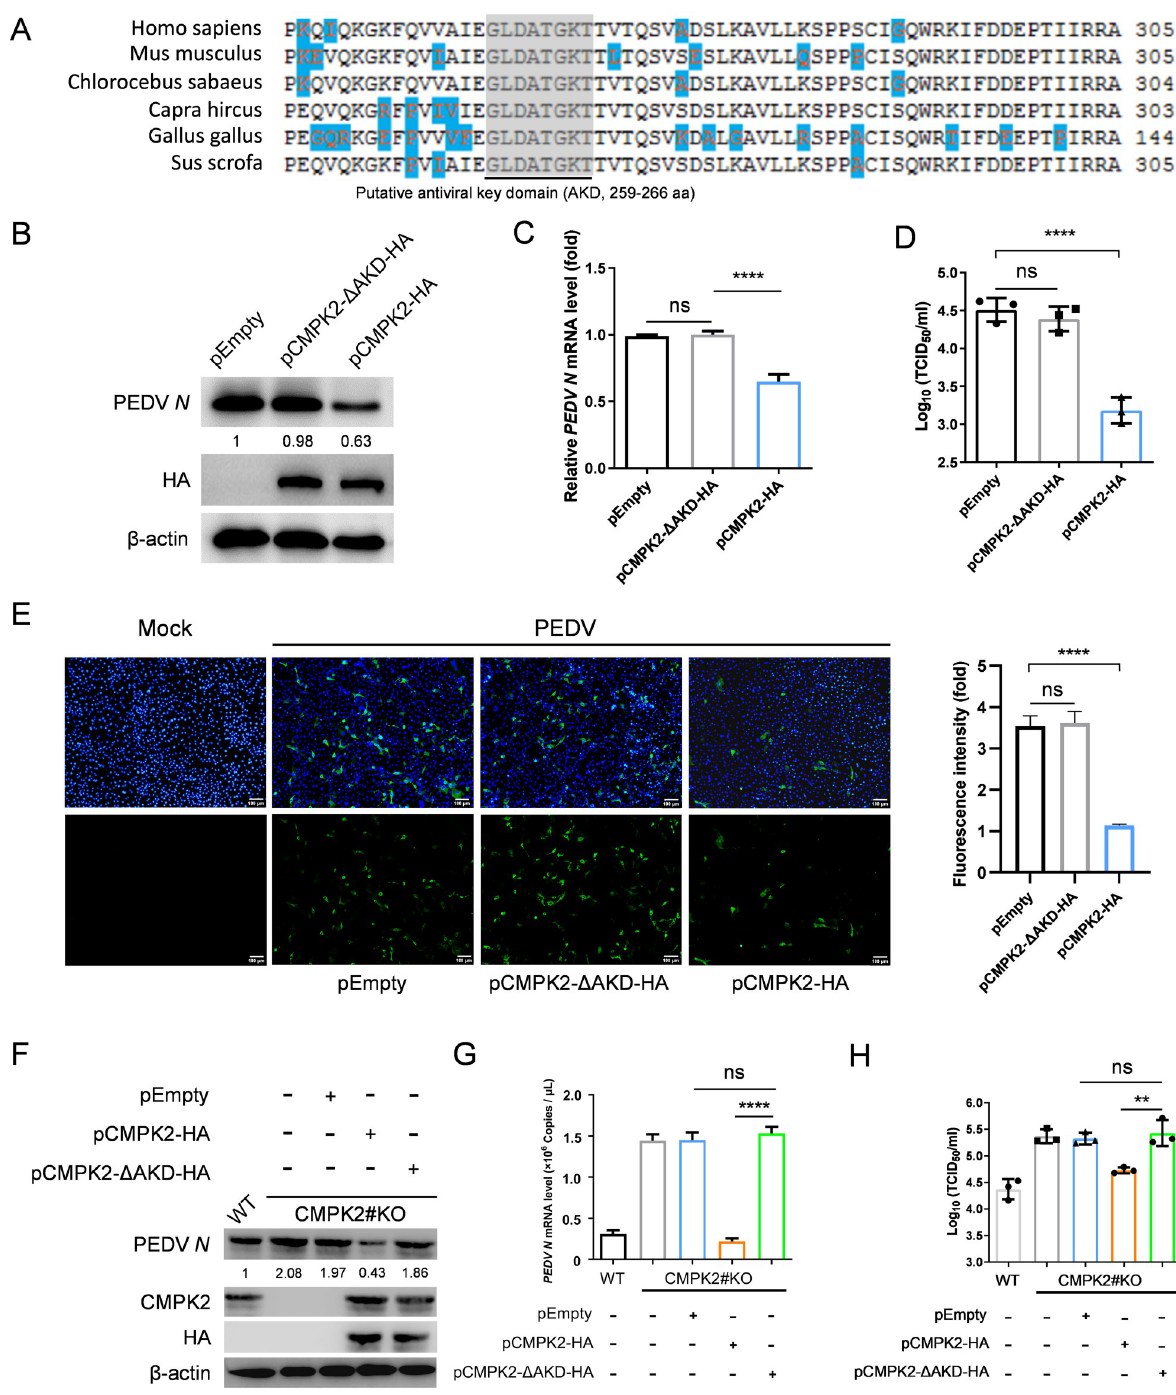
Fig 6. AKD domain is essential for CMPK2 exerting antiviral activity. (A) Alignment of Homo sapiens (NM_207315.4), Mus musculus (NM_020557.4), Chlorocebus sabaeus (XM_007971579.2), Capra hircus (XM_018055703.1), Gallus gallus (XM_015284945.4), and Sus scrofa (XM_021087907.1) CMPK2 amino acid sequences using the Megalign software, and the AKD was predicted using the UniProt database. Gray indicates sequence conservation. Blue indicates different amino acids among the above species. (B-C) IPEC-J2 cells were transfected with CMPK2- Δ AKD-HA, CMPK2-HA, and empty vector followed by PEDV infection for 20 hpi. The cell lysates were analyzed by western blotting ( B ), and total RNA of the cells were extracted and analyzed by qRT-PCR ( C ). (D) Culture supernatants were collected at 20 hpi, and PEDV titers were measured as TCID 50 . (E) PEDV in the cells overexpression CMPK2 with or without AKD deletion was detected by indirect IFA. PEDV N (green), DAPI (blue). Scale bars, 100 μ m. (F-G) CMPK2 knockout IPEC-J2 cells were transfected with CMPK2- Δ AKD-HA and empty vector for 24 h and then infected